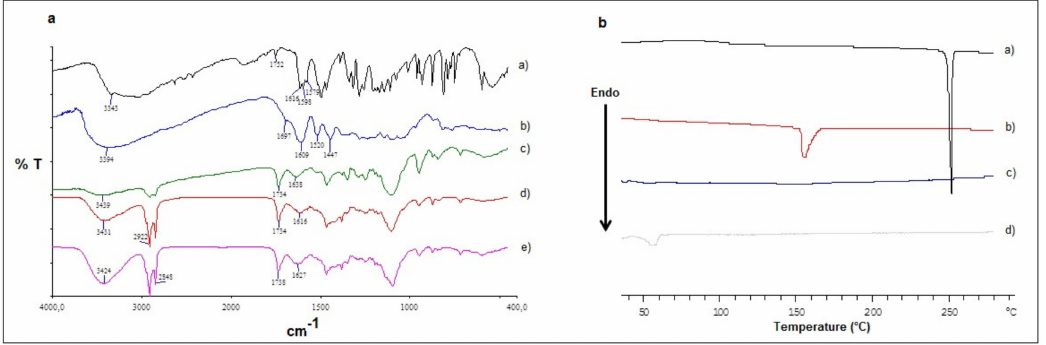
Figure 3. Panel ( a ): FT-IR spectra of pure DA ( a ), pure GSE ( b ), DA-SLN ( c ), GSE/DA-SLN ( d ) and GSE-SLN ( e ). Panel ( b ): DSC thermograms of pure DA ( a ), pure GSE ( b ), DA-SLN ( c ) and GSE/DA-SLN ( d ). In particular, in the FT-IR spectrum of GSE/DA-SLN, three characteristic absorption bands were noted at 3431 cm − 1 , 1734 cm − 1 and 1616 cm − 1 which were also present in the spectra of the other corresponding SLN formulations (i.e., DA-SLN and GSE-SLN) even though slightly shifted. It should be noted that the absorption bands at 3431 cm − 1 , and 1734 cm − 1 could be ascribed to partially hydrated Gelucire ® 50/13, while in all these spectra the characteristic peaks attributable to pure DA and pure GSE at 1616–1579 cm − 1 and at 1609 cm − 1 , respectively, were not distinctly detected [26,27]. In the DSC thermogram of GSE/DA-SLN the endothermic peaks attributable to the melting of pure DA and